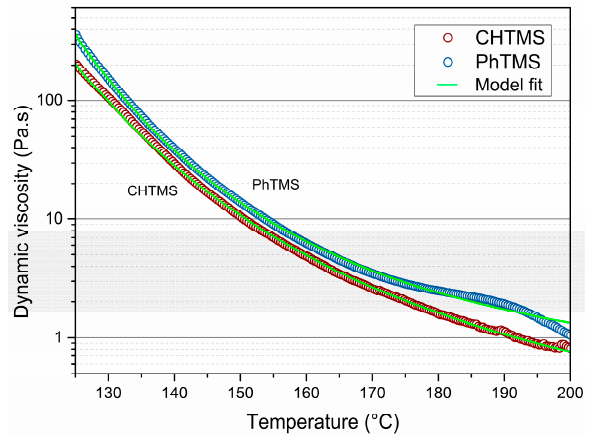
Figure 2. Dynamic mechanical analysis (DMA) curves of CHTMS and PhTMS polymers. The curves were recorded after the formation of a melt. Masuko-Magill model fits to the experimental data are plotted as green lines. The blue bands represent the range of values of the two references recorded at different temperatures.